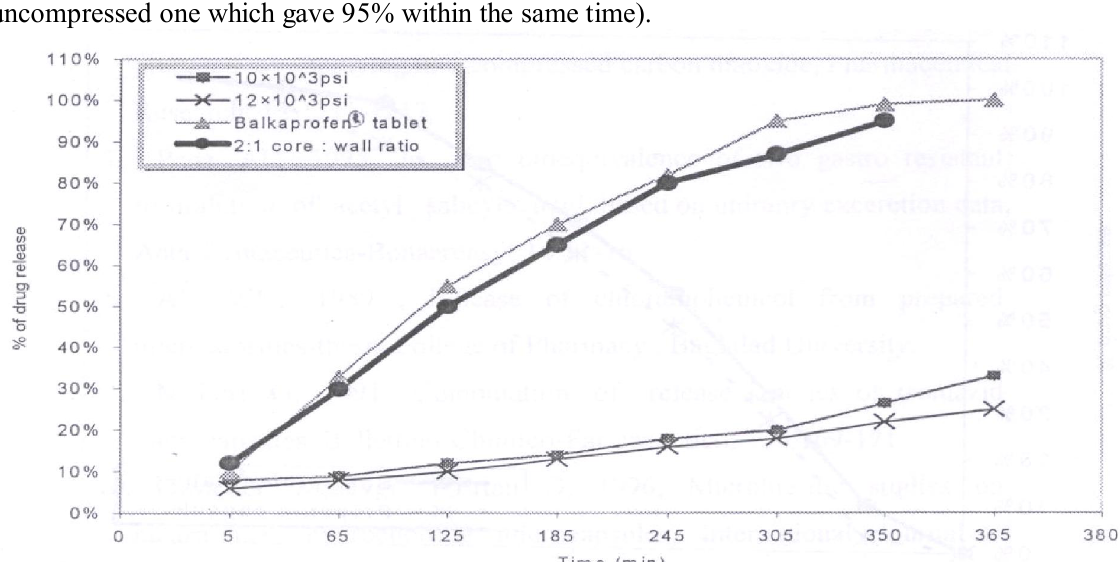
Figure (4): Effect of compression forces on the dissolution of compared tabletted ibuprofen micro prepared by a modified organic method in comparison with Balkprofen ® tablet using pH 6.8 phosphate buffer at